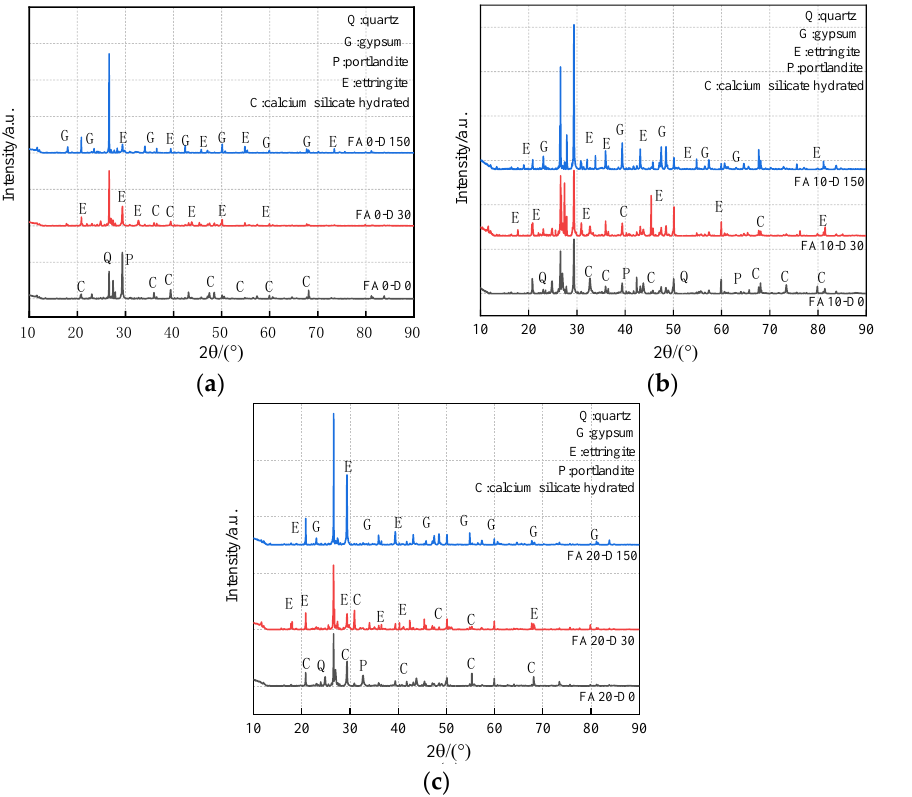
Figure 11. X-ray diffraction patterns of concrete subjected to sulfate attack. ( a ) FA0 concrete; ( b ) FA10 concrete; and ( c ) FA20 concrete.